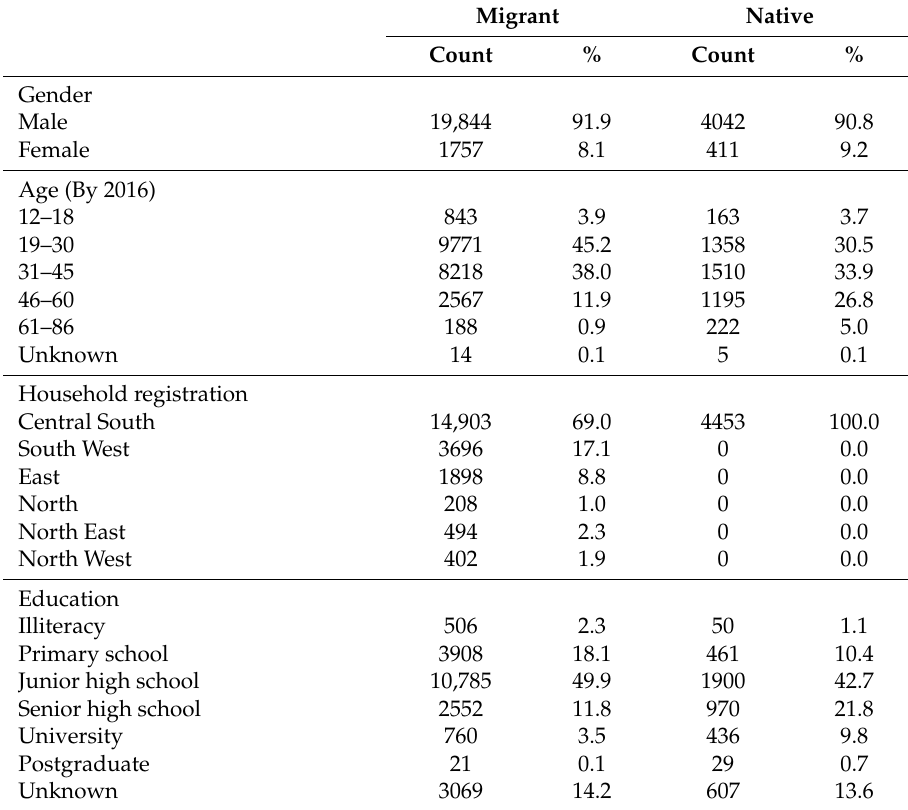
Table 2. Characteristics of migrant and native violent